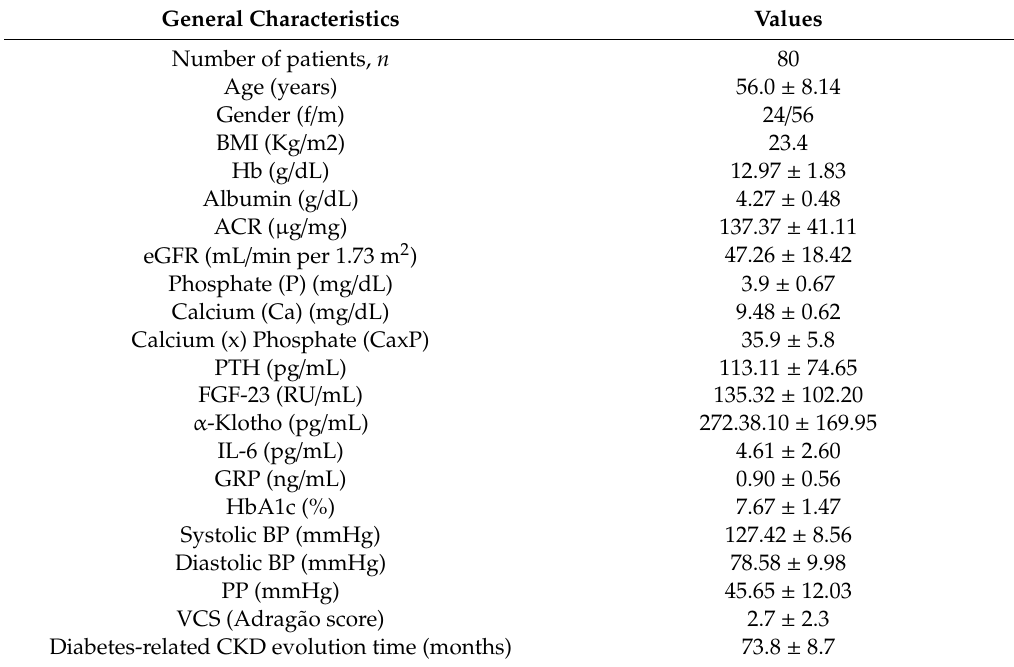
Table 1. Baseline patient characteristics (n =